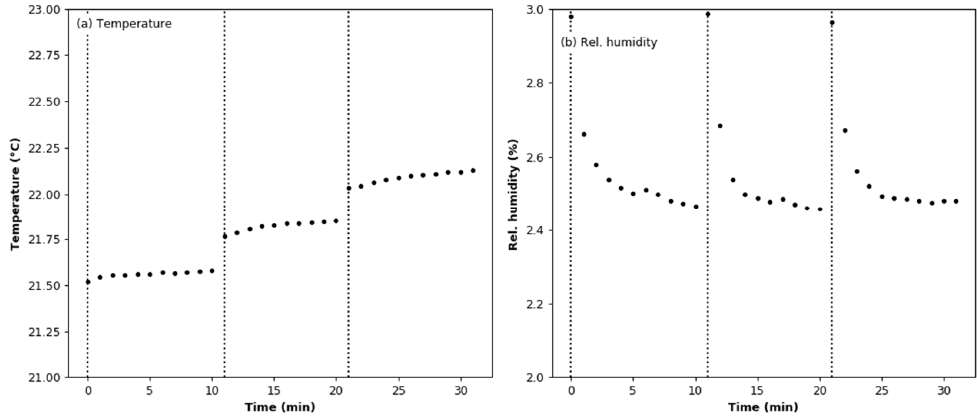
8 of 15 Figure 9. Readings from aerosol detectors during argon additions: ( a ) total number concentrations measured by the MiniWRAS; ( b ) output signal from the smoke detector. 3.4. Effect of Aerosol under Constant Humidity Conditions In this experiment, measurements with an aerosol concentration below the MiniWRAS lower detection limit were removed from the recorded dataset. Changes in the temperature and humidity during the test are shown in Figure 10. The vertical lines indicate the moments at which test aerosol was added to the test chamber. The mean val- ues of the temperature and relative humidity are 21.82 °C ± 0.22 °C and 2.56% ± 0.15%,